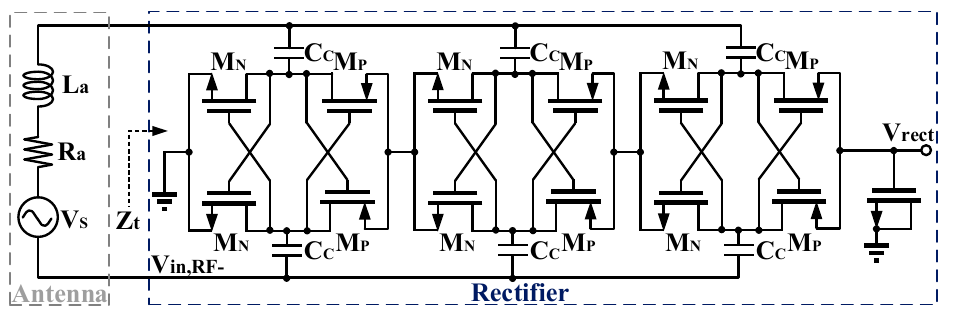
Figure 4. Schematic of proposed radio frequency identification (RF) energy-harvesting circuit.